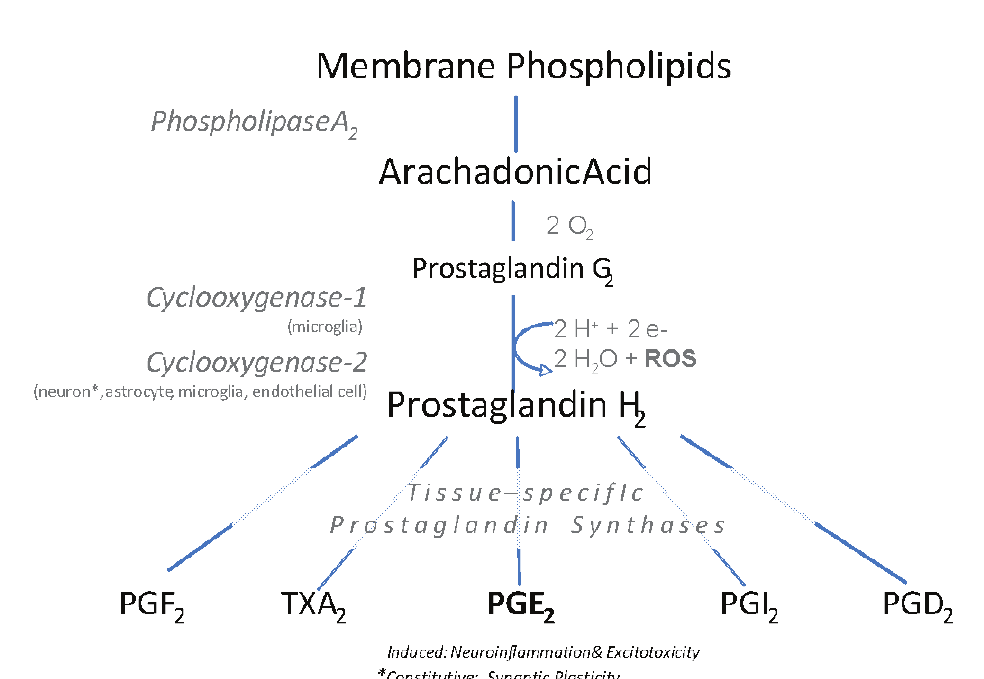
Figure 1. Prostaglandin synthesis with attention to cyclooxygnease expression in neural cells and function of PGE in brain. Modified from 2